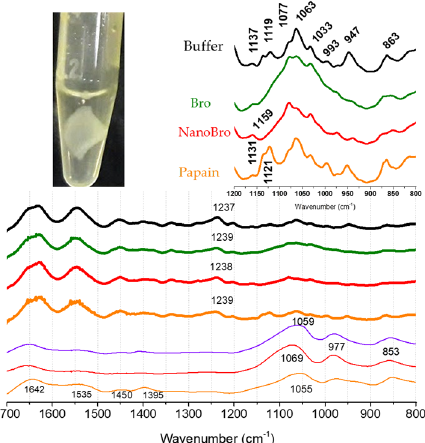
Figure 7. FTIR spectra of collagen membranes (tick solid lines) and supernatant solution (thin solid lines) after enzymatic activity of papain (orange lines), NanoBro (red lines) and Bro (green lines). Membrane spectrum incubated with buffer alone is represented by thick solid black line.